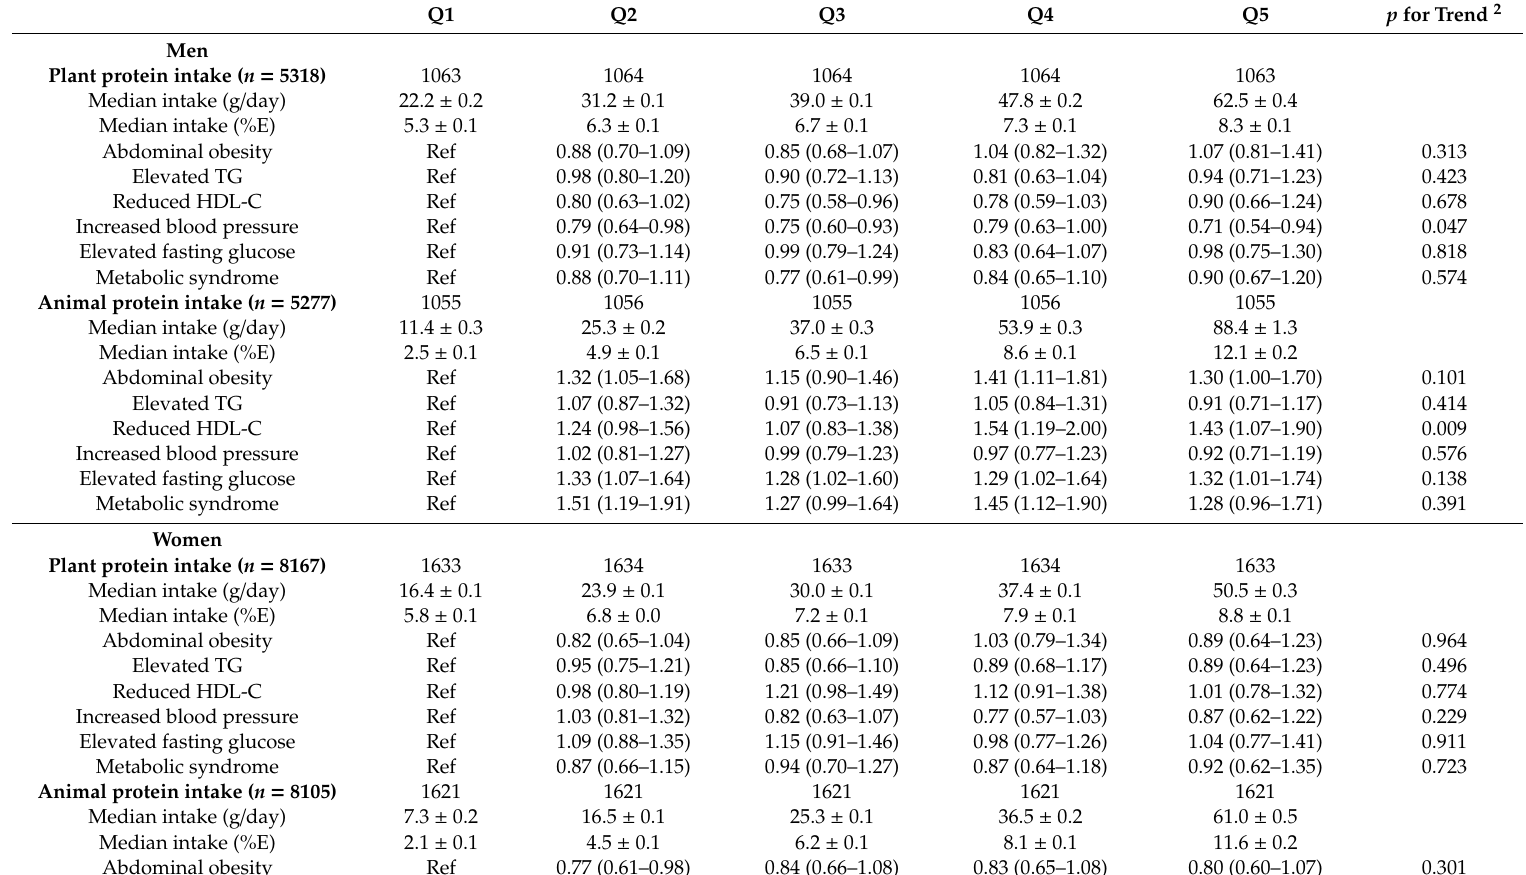
Table 4. Odds ratios and 95% confidence intervals for metabolic syndrome parameters 1 according to quintiles of plant and animal protein intake in Korean adults aged 30–64